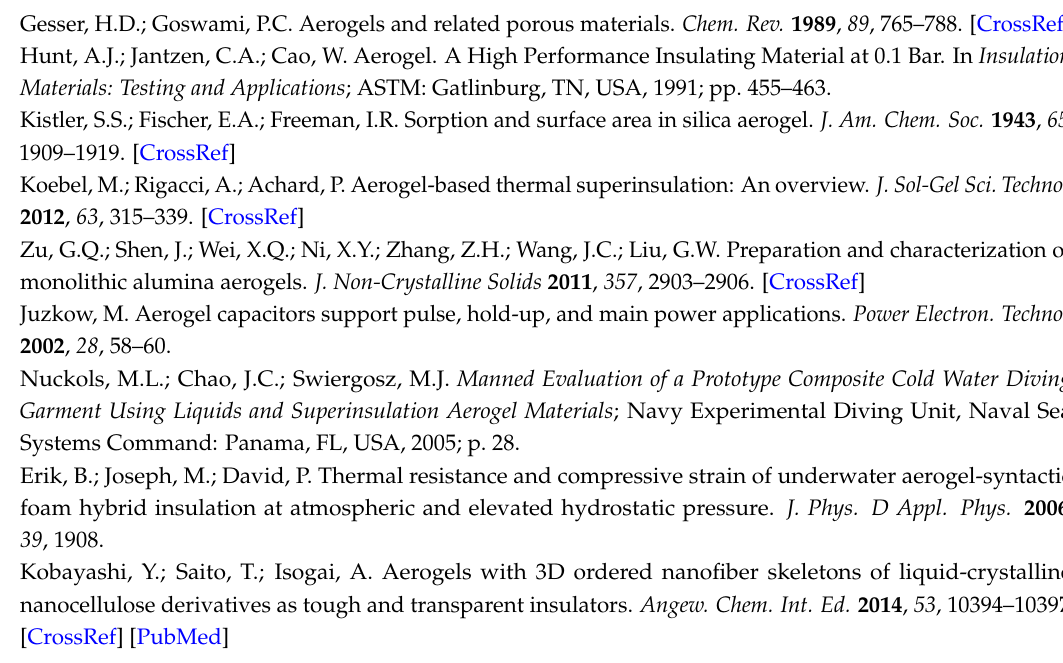
Figure 12. Experimental setup using the B&K Type 4206 Impedance Tube Kit as per ASTM E1050.